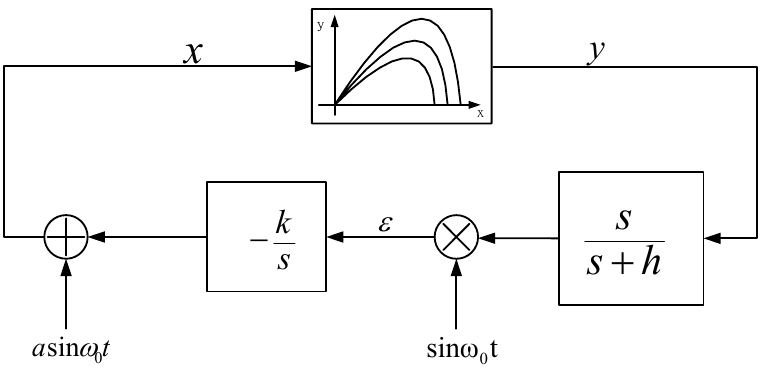
Figure 9. A block diagram of a sinusoidal ESC system.